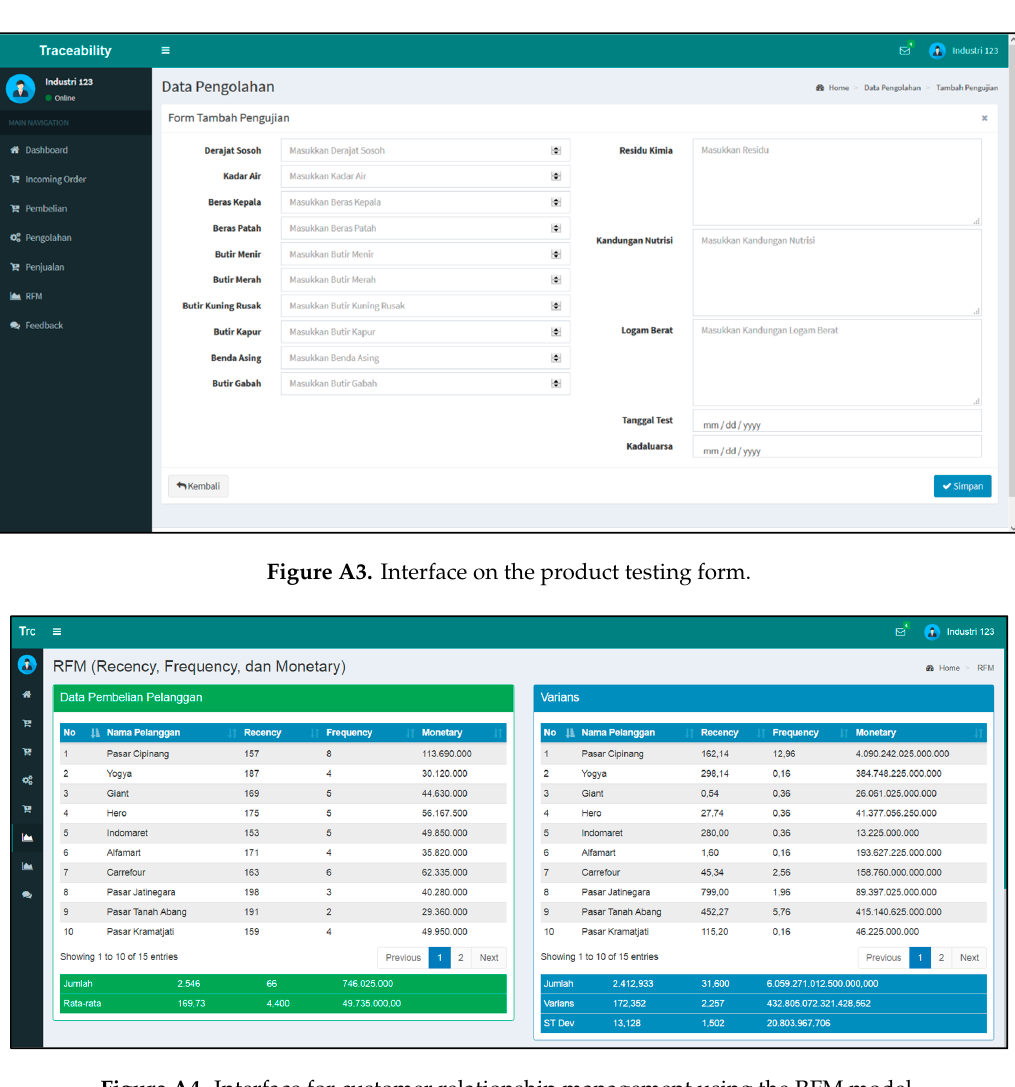
Figure A4. Interface for customer relationship management using the RFM model.